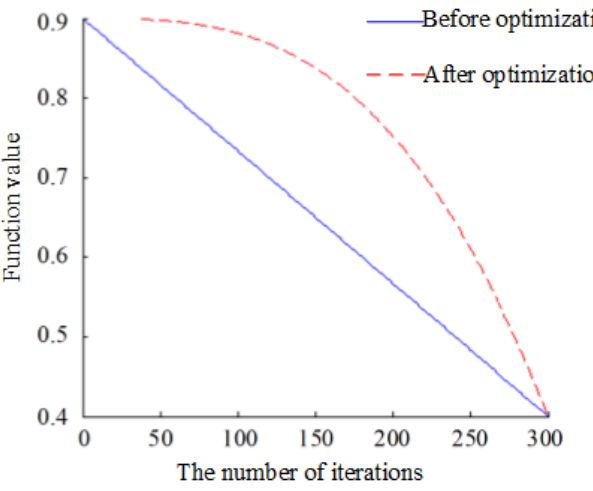
Figure 4. The change of two inertia weight.